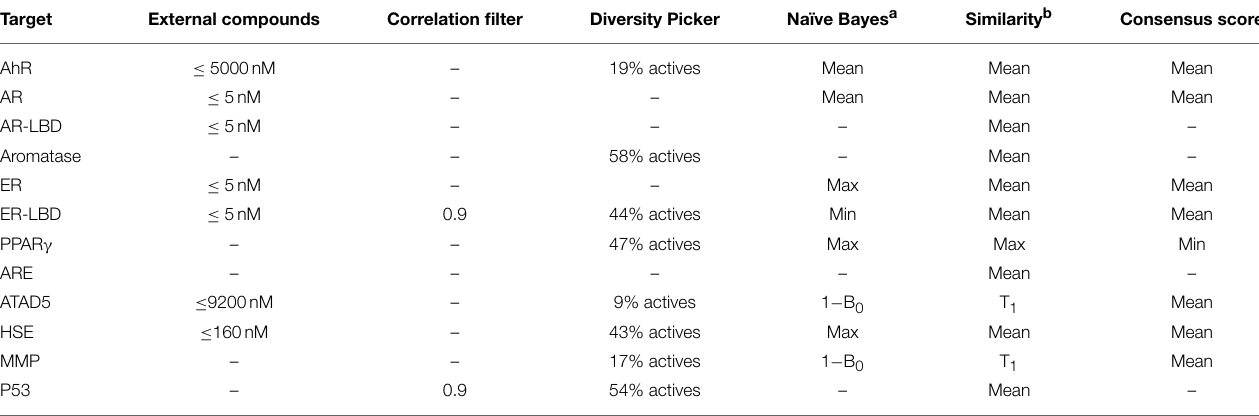
TABLE 2 | Parameters of the most successful prediction models.